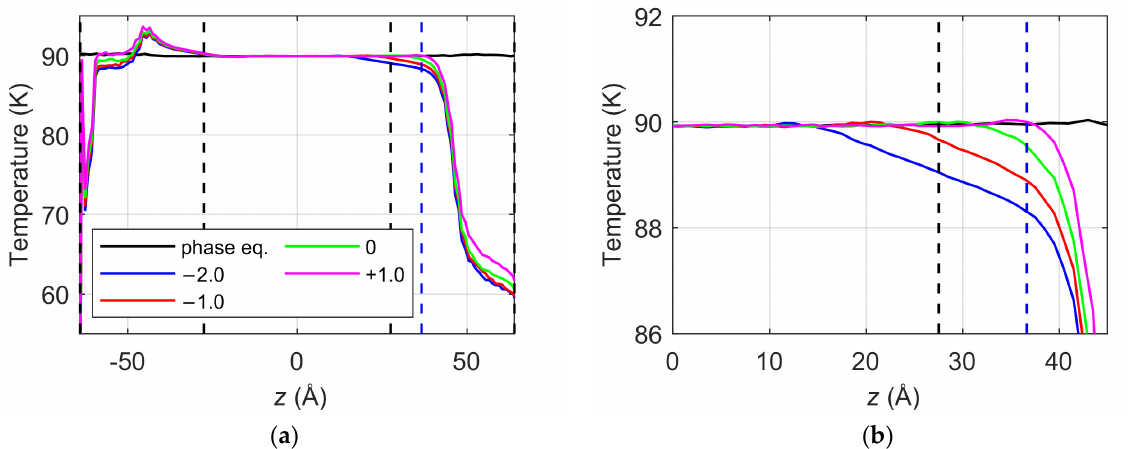
Figure 8. ( a ) The temperature profiles from simulations with different thermostat region boundary positions at the right-side interface, and ( b ) the zoomed view of these profiles in the liquid region near the liquid surface. The black dotted lines denote the liquid and vapor boundary positions z ∗ = − 0.9 and z ∗ = 3 for both left- and right-side interfaces, while the blue dotted line denote the liquid surface position z ∗ = 0. For comparison, the temperature profile from the phase equilibria simulation is also plotted.